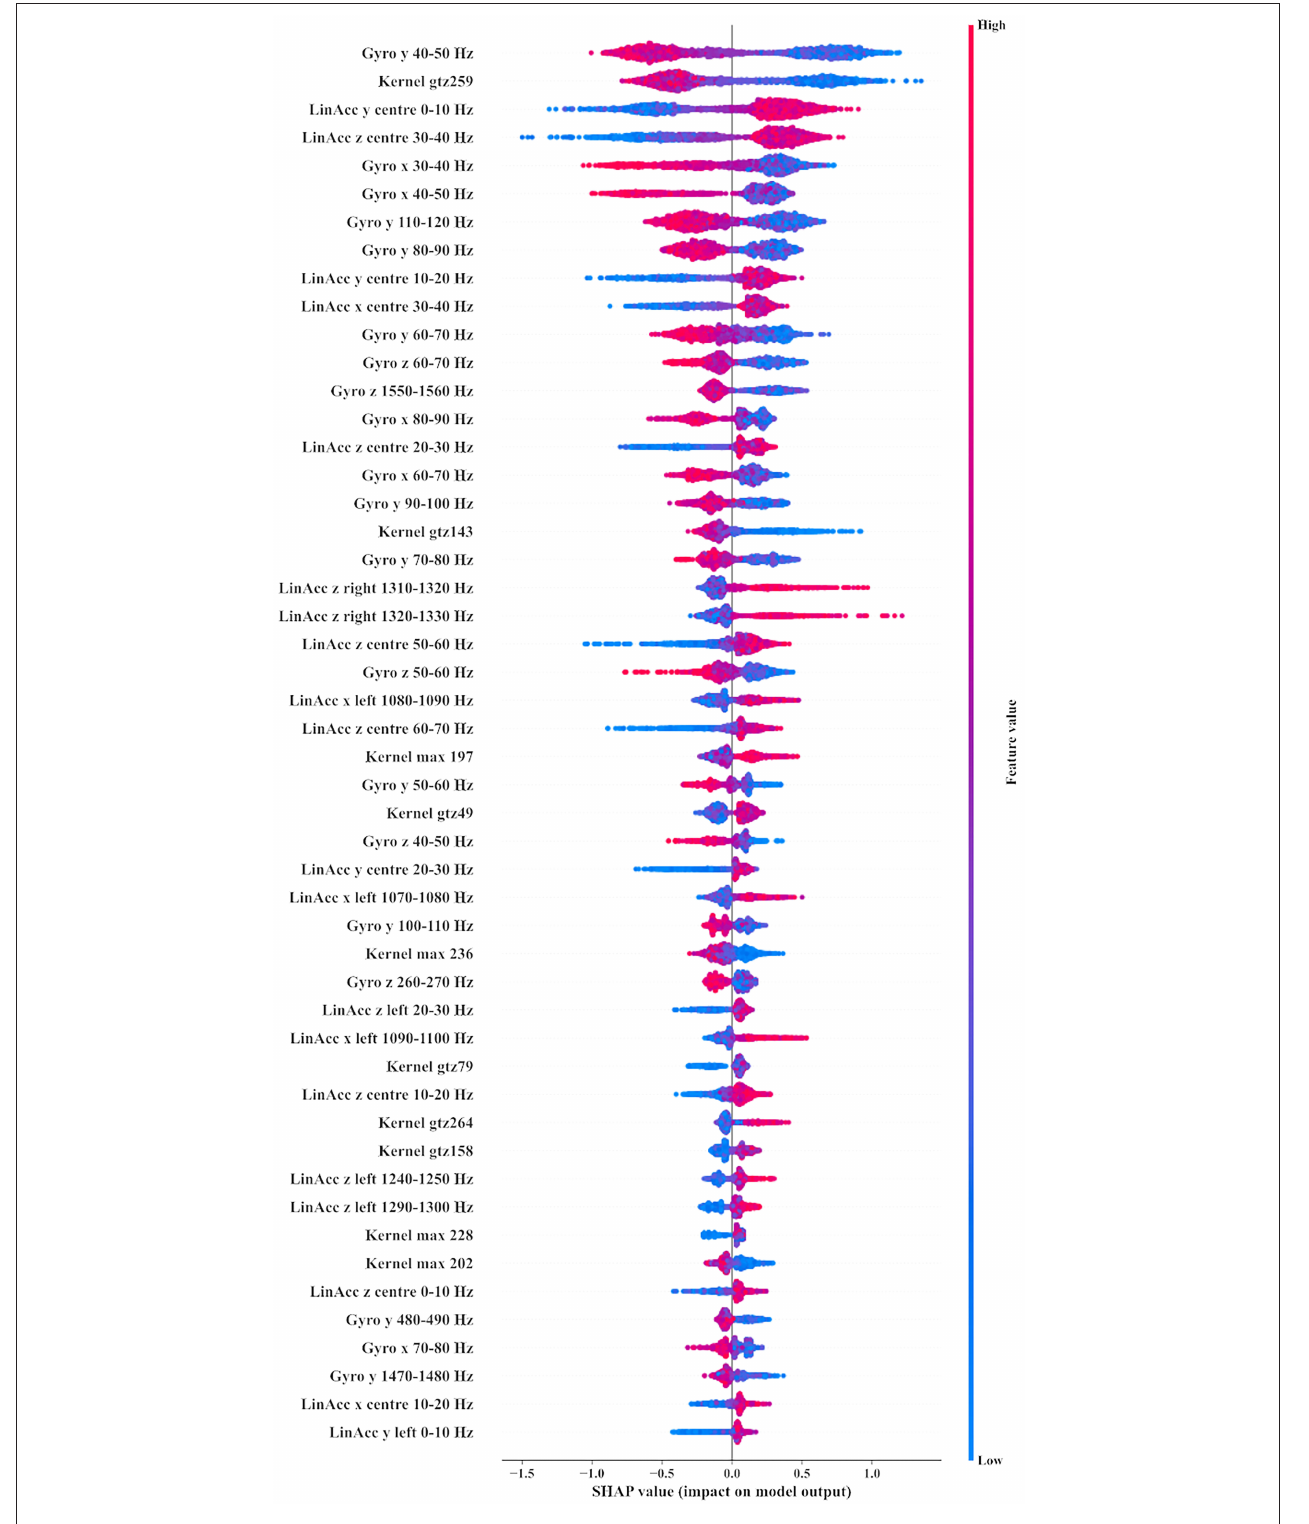
FIGURE 1 | Top 50 features used by the XGBoost model. Gyro, Gyrometer; LinAcc, Linear accelerometer; x, X axis; y, Y axis; z, Z axis; Kernel, Convolutional kernel; max, Maximum value of kernel; ppv, Proportion of Positive Values in kernel. Values above 0 indicate contribution toward a positive label (hit), while values below 0 are contributions to a non-hit